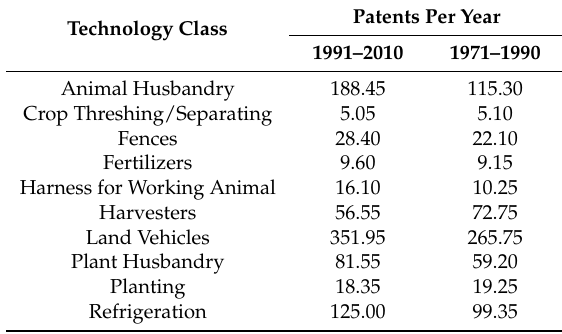
Table 2. Individually owned agriculture-related patents in the U.S.,